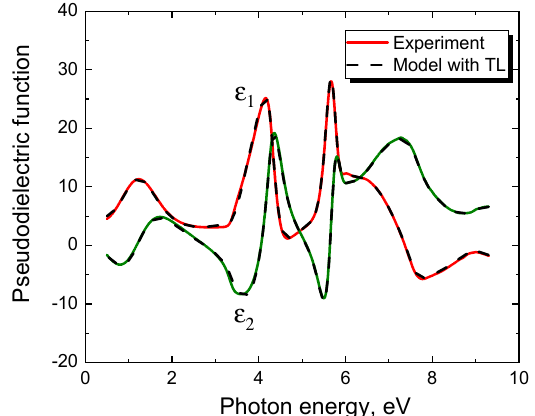
Figure 10. Comparison between the experimental (solid line) and theoretical (dashed line) depend- ences of the pseudodielectric constant ε on the photon energy of a 3C-SiC(111)/Si(111) sample grown by the method of substitution of atoms on a Si(111) substrate. The theoretical curve was obtained on the basis of an ellipsometric model with a semimetal layer at the interface (Figure 9).